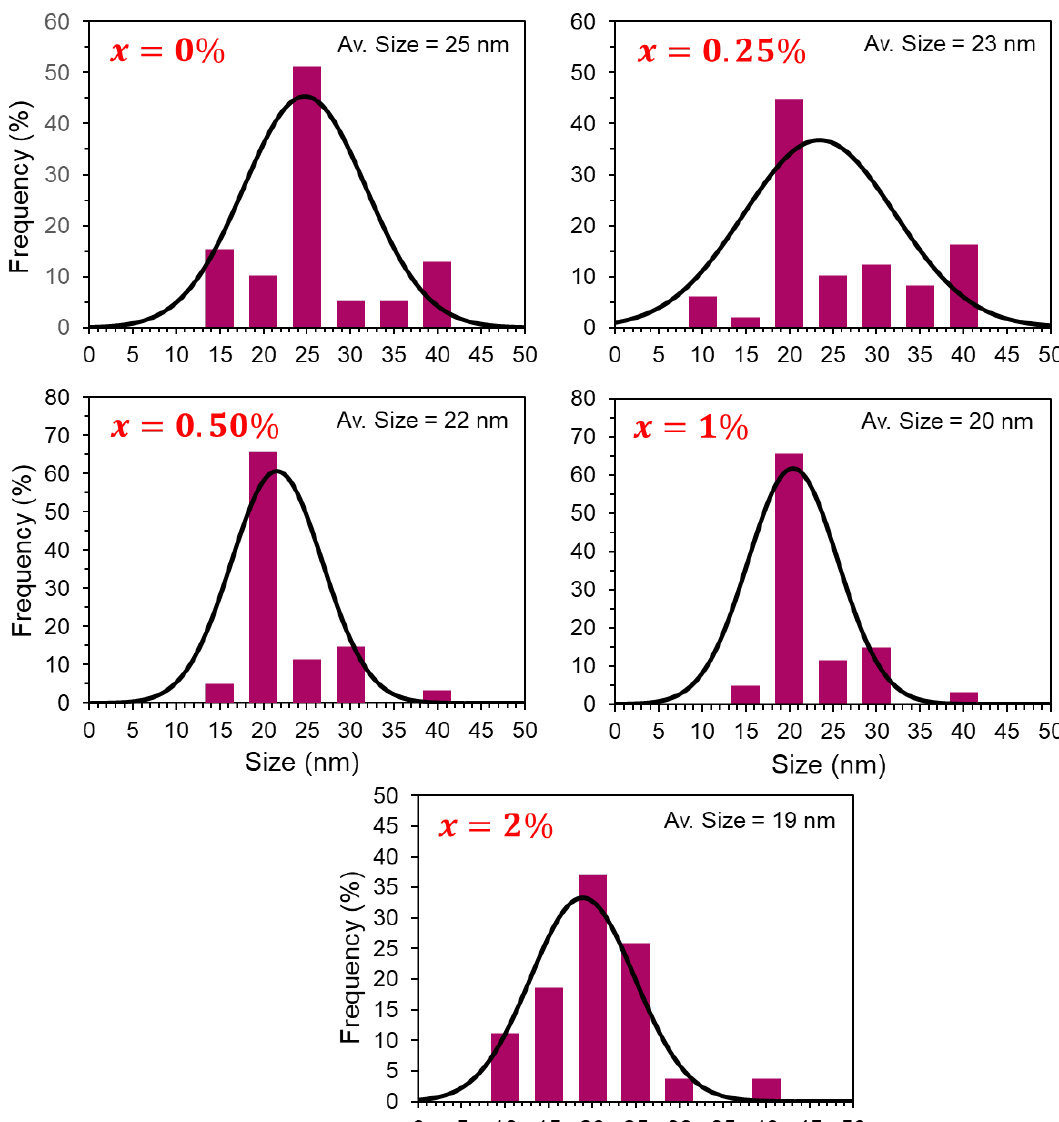
Figure 3. Histograms representing nanoparticles’ size distribution of Ce–Sm co-doped TiO 2 nanoparticles ( x = 0, 0.25, 0.50, 1, and 2%).